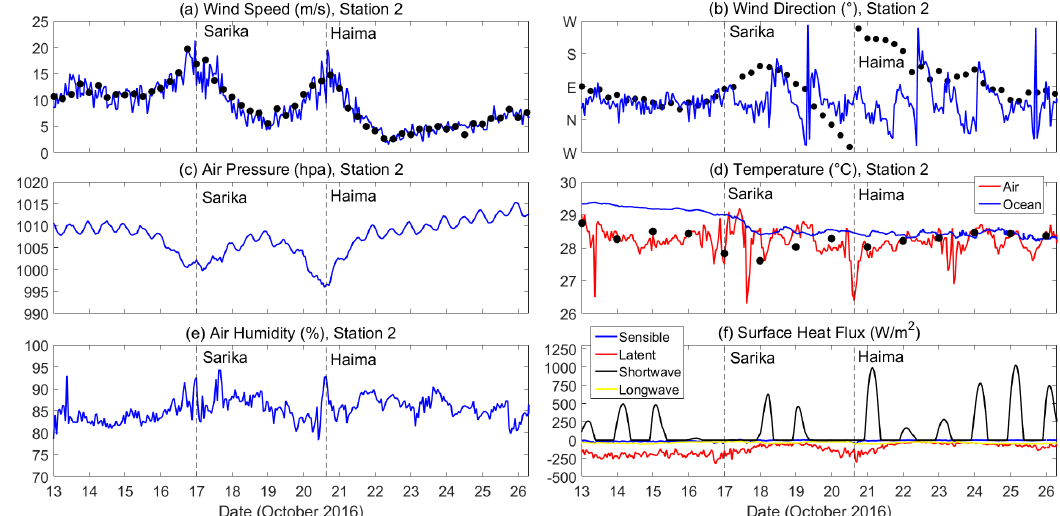
Figure 7. Time series of the ( a ) sustained surface wind speed, ( b ) wind direction, ( c ) air pressure, ( d , red) surface air temperature, ( d , blue) sea surface temperature, ( e ) air humidity, surface fluxes of the (f, blue) sensible heat, ( f , red) latent heat, ( f , black) short wave radiation, and ( f , orange) long wave radiation at Station 2 during Sarika and Haima. Regarding the wind directions, N, W, S, and E indicate the approach directions of the winds, namely, north, west, south, and east, respectively. The vertical black dashed lines represent the times when Sarika and Haima were closest to Station 2. Black dots in ( a , b , d ) were the remote sensingsatelliate data of cross-calibrated multi-platform (CCMP) wind and Microwave optimally interpolated sea surface temperature (OI